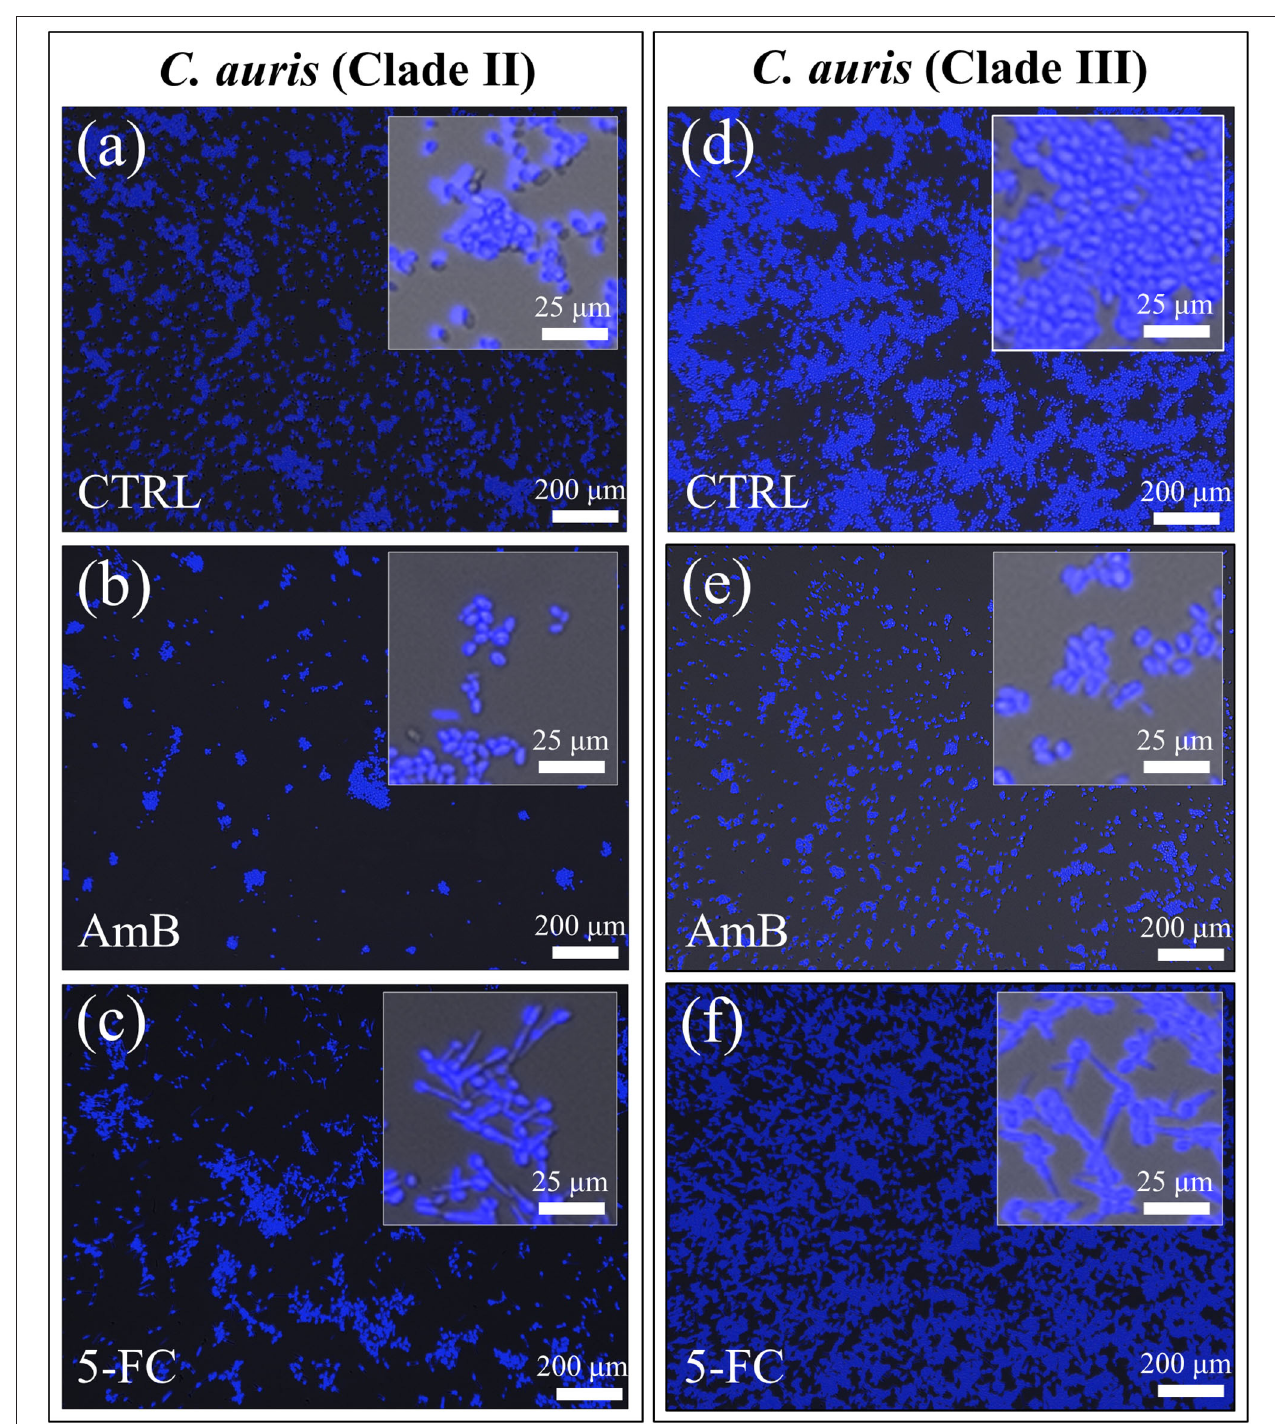
FIGURE 3 | Confocal laser micrographs of violet Filipin blue-stained C. auris cultures before (CTRL label) and after 24h treatment with different drugs (cf. labels in inset): Clade II (a–c) and Clade III (d–f) . The micrographs stain ergosterol in blue color. Filipin blue outputs were in line with the PAS violet ones (cf. Fig. 2) showing the most significant reduction in cell density upon AmB treatment [cf. (b,e) for Clades II and III, respectively] and the occurrence of hyphal morphogenesis in 5-FC treated cultures of both clades [cf. enlarged images in inset to (c,f) ].